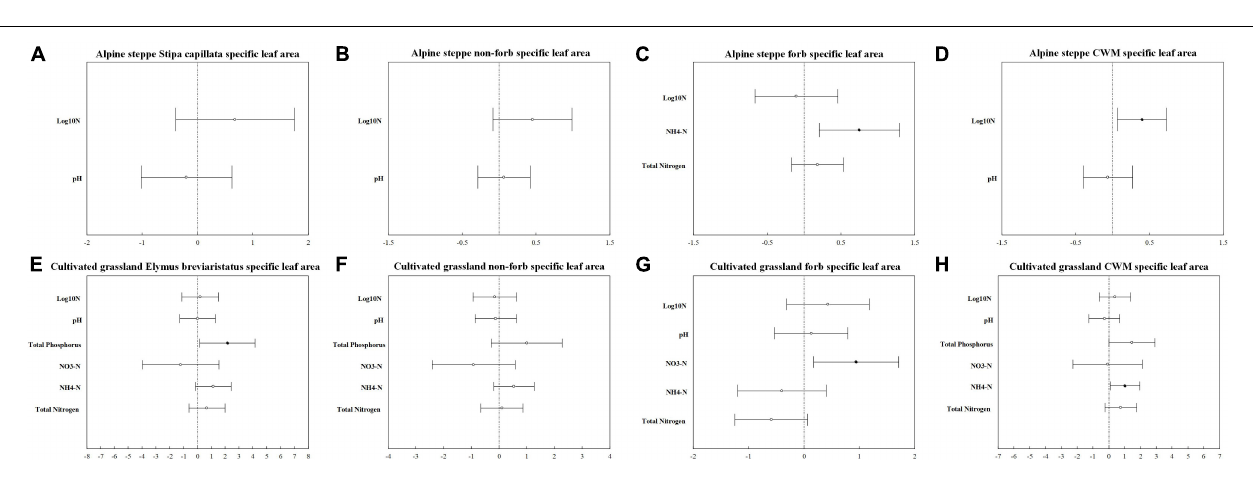
forb functional group in the AS ( Figure 2C ). Ammoniacal N